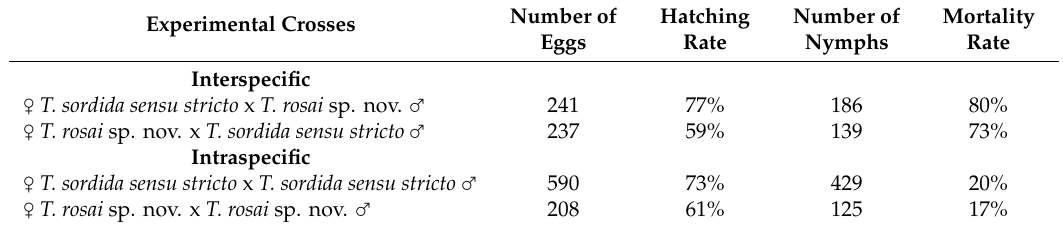
Number Hatching Number of Mortality of Eggs Rate Nymphs Rate